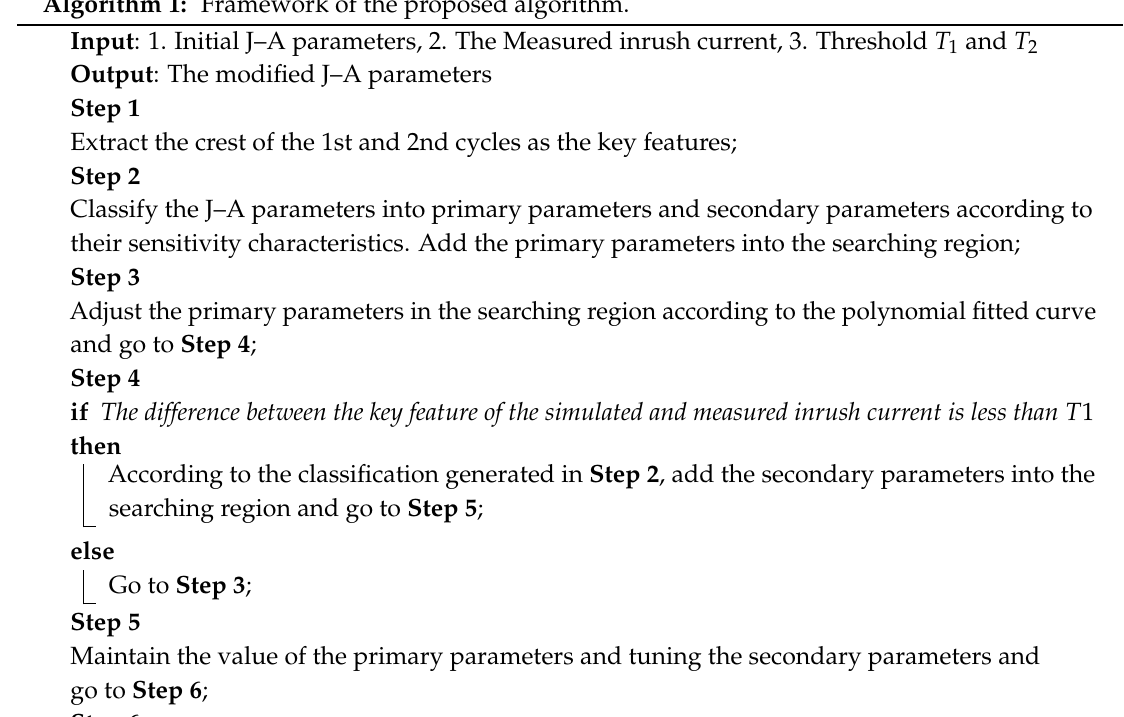
Algorithm 1: Framework of the proposed algorithm.